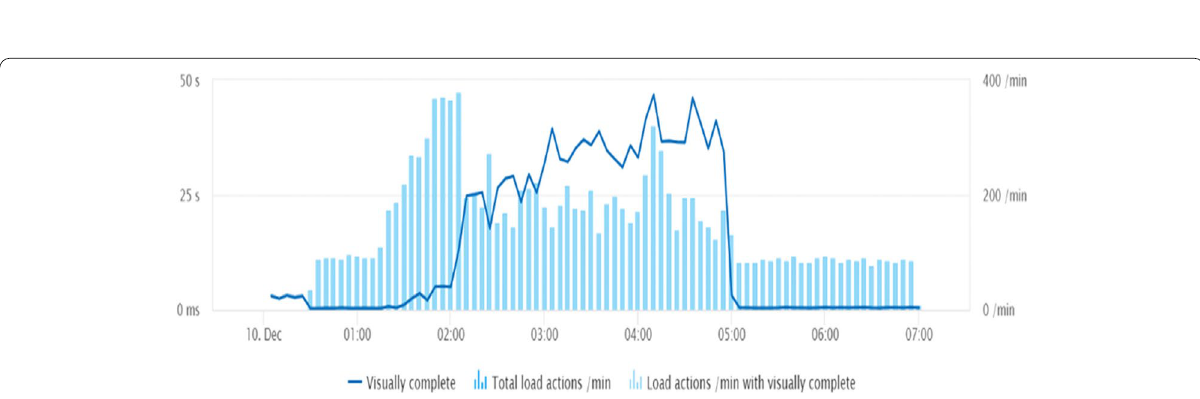
Fig. 11 Monolith response time vs. the number of